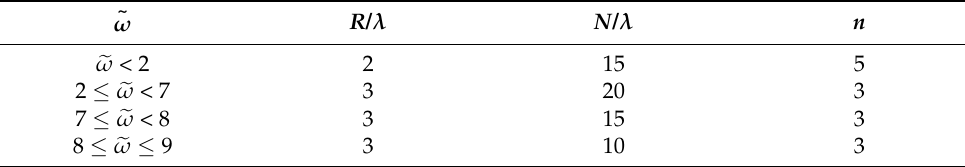
Table 2. Optimum PML parameters for (cid:101) σ =